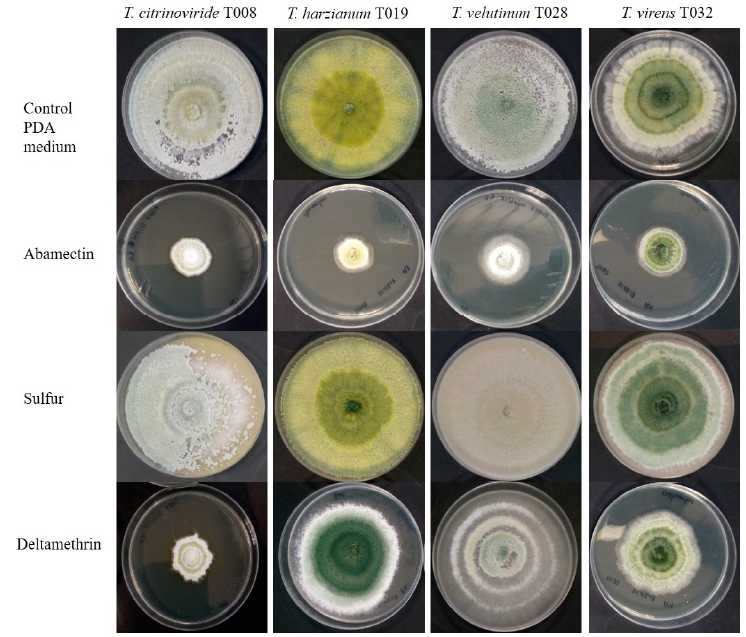
Figure 3. Growth of autochthonous Trichoderma strains in medium with synthetic acaricide at day 5 after inoculation.